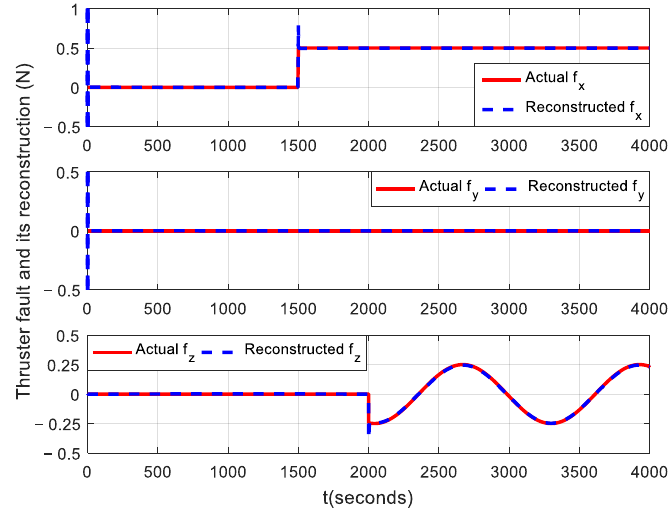
Figure 3. Reconstruction signals from the different fault scenarios.